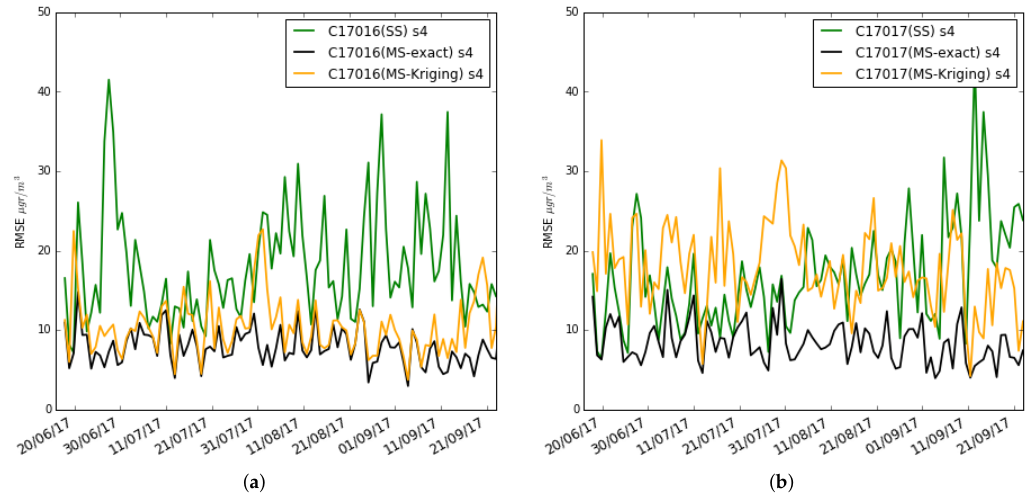
Figure 19. Case 3: Test RMSE with training set of 3 weeks, single-scale versus multi-scale with exact correction and Kriging estimation, ( a ) daily in s 4 of Captor 17016 (Vic), ( b ) daily in s 4 of Captor 17017